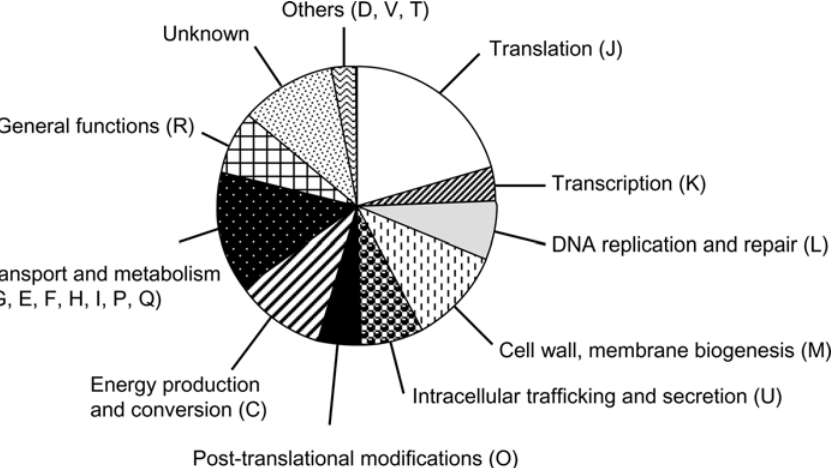
Figure 4. Distribution of R.conorii ORFs down-regulated during infection. Pie chart showing the percentages of transcripts down-regulated in eschars and classified according to their respective functional categories. COG category legend is as follow: Cell cycle control, mitosis and meiosis (D); Defense mechanisms (V); Signal transduction mechanisms (T); Transport and metabolism of carbohydrates (G), amino acids (E), nucleotides (F), coenzymes (H), lipids (I), inorganic ions (P), and of secondary metabolites (Q).